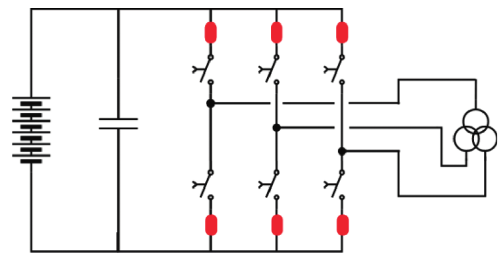
Figure 2: Traction inverter’s high-low side short-circuit detecting location.